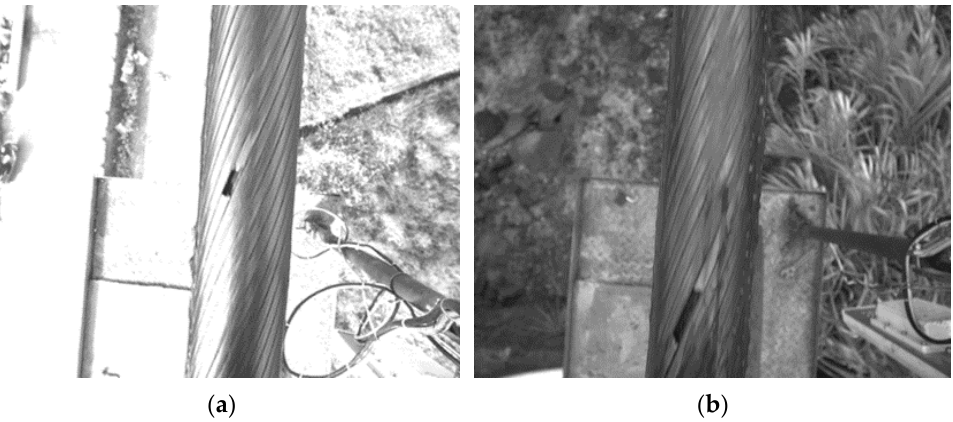
Figure 11. Wire rope image with a defect. ( a ) Strong light; ( b ) Weak light. Steel wire rope surface defect detection method based on segmentation template and spatiotemporal gray sample set (STSGSS) is shown in the algorithm in Algorithm 2. The steel wire rope segmentation template is created in advance, and the problem of rope strand segmentation in real-time images in complex environments is solved. On this basis, continuous 𝑡 -frame images are collected to build a spatiotemporal gray sample set, the content of the sample set is updated in real-time, the dynamic background modeling of the steel wire rope surface is realized, the distance between each pixel in the current image and its sample set is calculated, and the foreground defect area on the surface of steel wire rope is detected. Algorithm 2. Steel wire rope surface defect detection method based on segmentation template and spatiotemporal gray sample set.